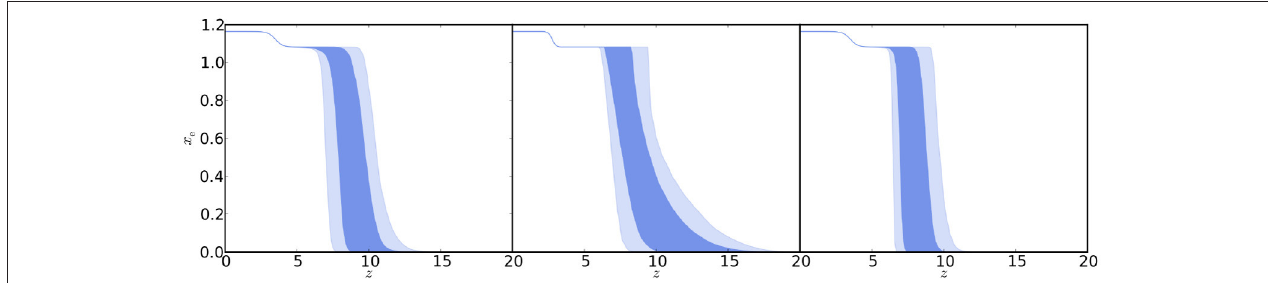
FIGURE 2 | “Constraints on ionization fraction during reionization. The allowed models, in terms of z re and 1 z , translate into an allowed region in x e ( z ) (68 and 95% in dark blue and light blue, respectively), including the z end > 6 prior here.” Left : “Constraints from CMB data using a redshift-symmetric function [ x e ( z ) as a hyperbolic tangent with δ z = 0.5].” Middle : “Constraints from CMB data using a redshift-asymmetric parameterization ( x e ( z ) as a power law).” Right : “Constraints from CMB data using a redshift-symmetric parameterization with additional constraints from the kSZE effect.” Reprinted from Planck Collaboration (2016e) [Credit: